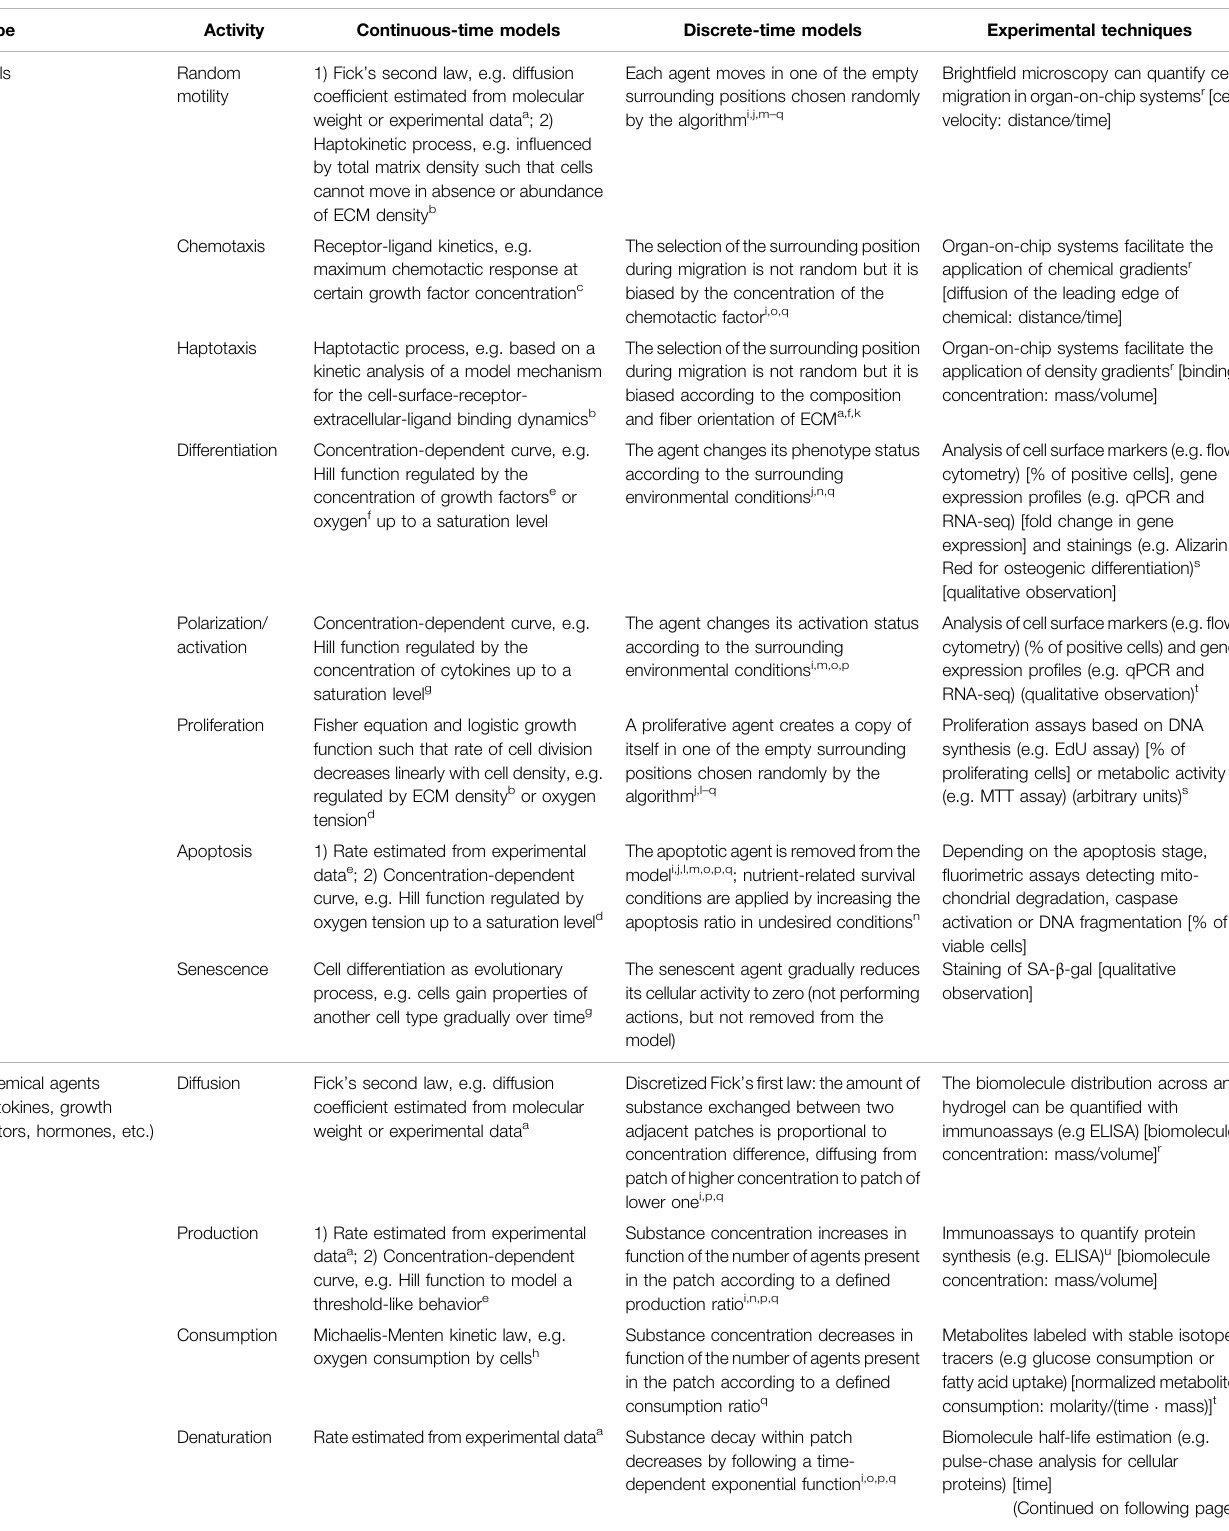
TABLE1| Overviewofthebiologicalagentsandprocessesinbonefracturehealingandthewaytheycanbecaptured insilico incontinuous-timeordiscrete-timemodels.In keeping with thedescription in Section 3.1 , thespatial scale(ifpresent)ismentioned.Examples are provided ofexperimental setups touseduring thecalibrationphase of in silico models. Units of quantitative parameters that can be extracted from experiments are in squared brackets. For those experiments that lead to qualitative observations, this is mentioned explicitly.